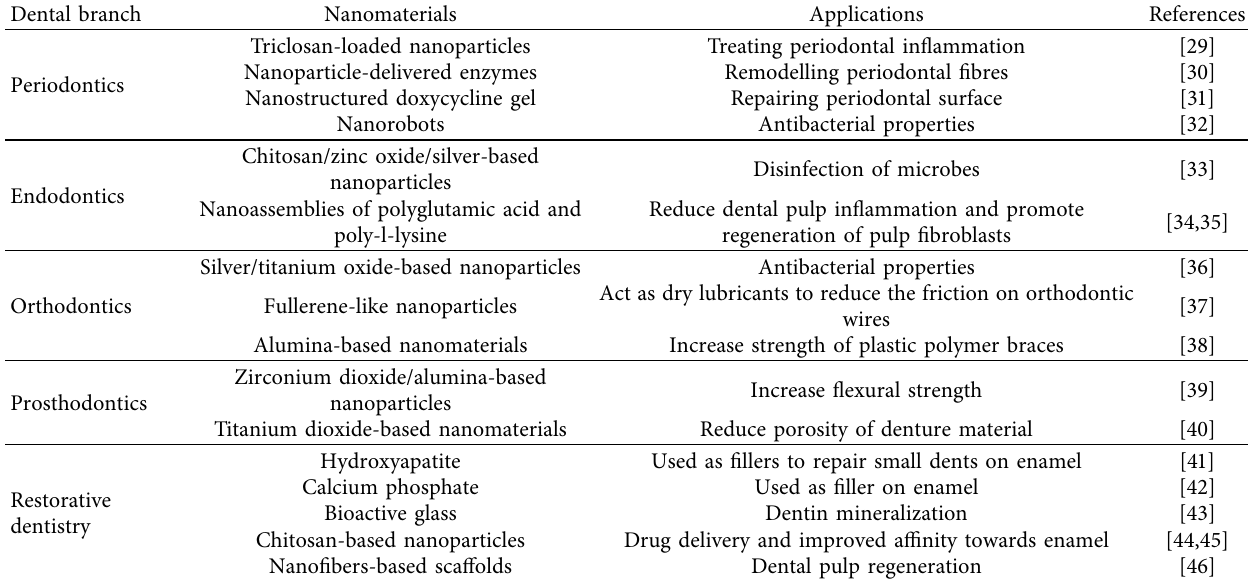
Figure 2: Various fields of dentistry currently using nanoparticles. Created using BioRender. Table 1: Current functions of nanoparticles across various branches of